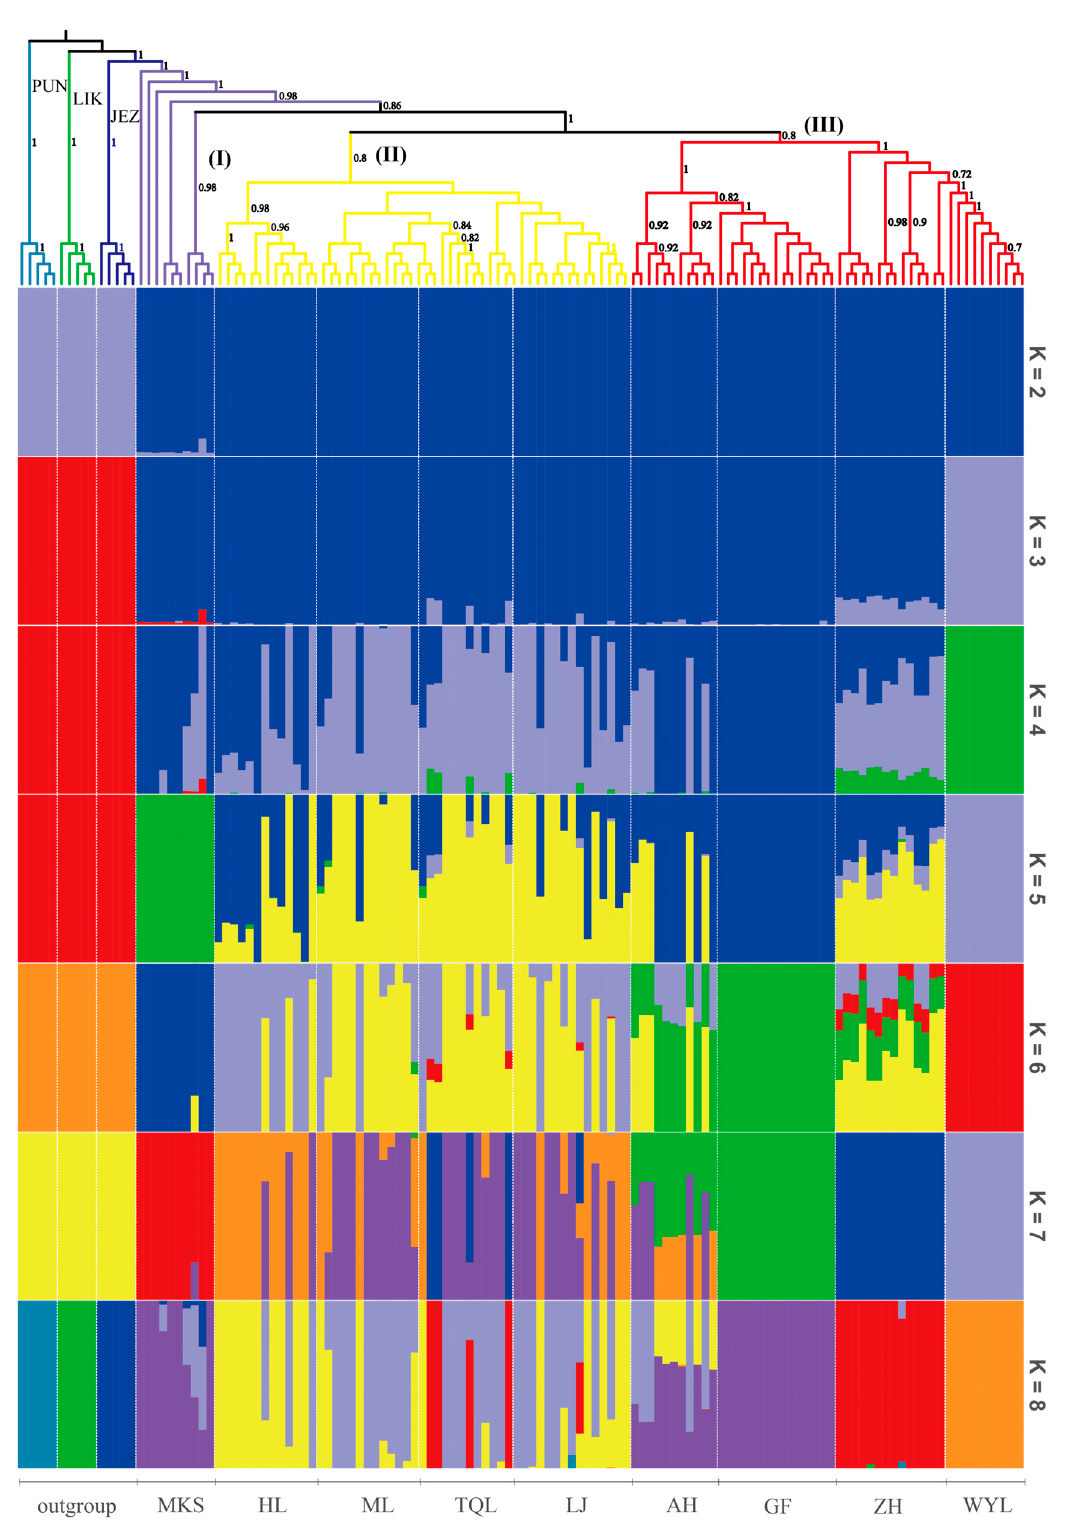
Figure 1. Phylogenetic tree and structure of 127 samples of P. koraiensis and outgroups with bootstrap value. PUN: Picea pungens ; LIK: Picea likiangensis ; JEZ: Picea jezoensis. I: Great Khingan Mountains group; II: Changbai Mountain group; III: Lesser Khingan Mountains group.